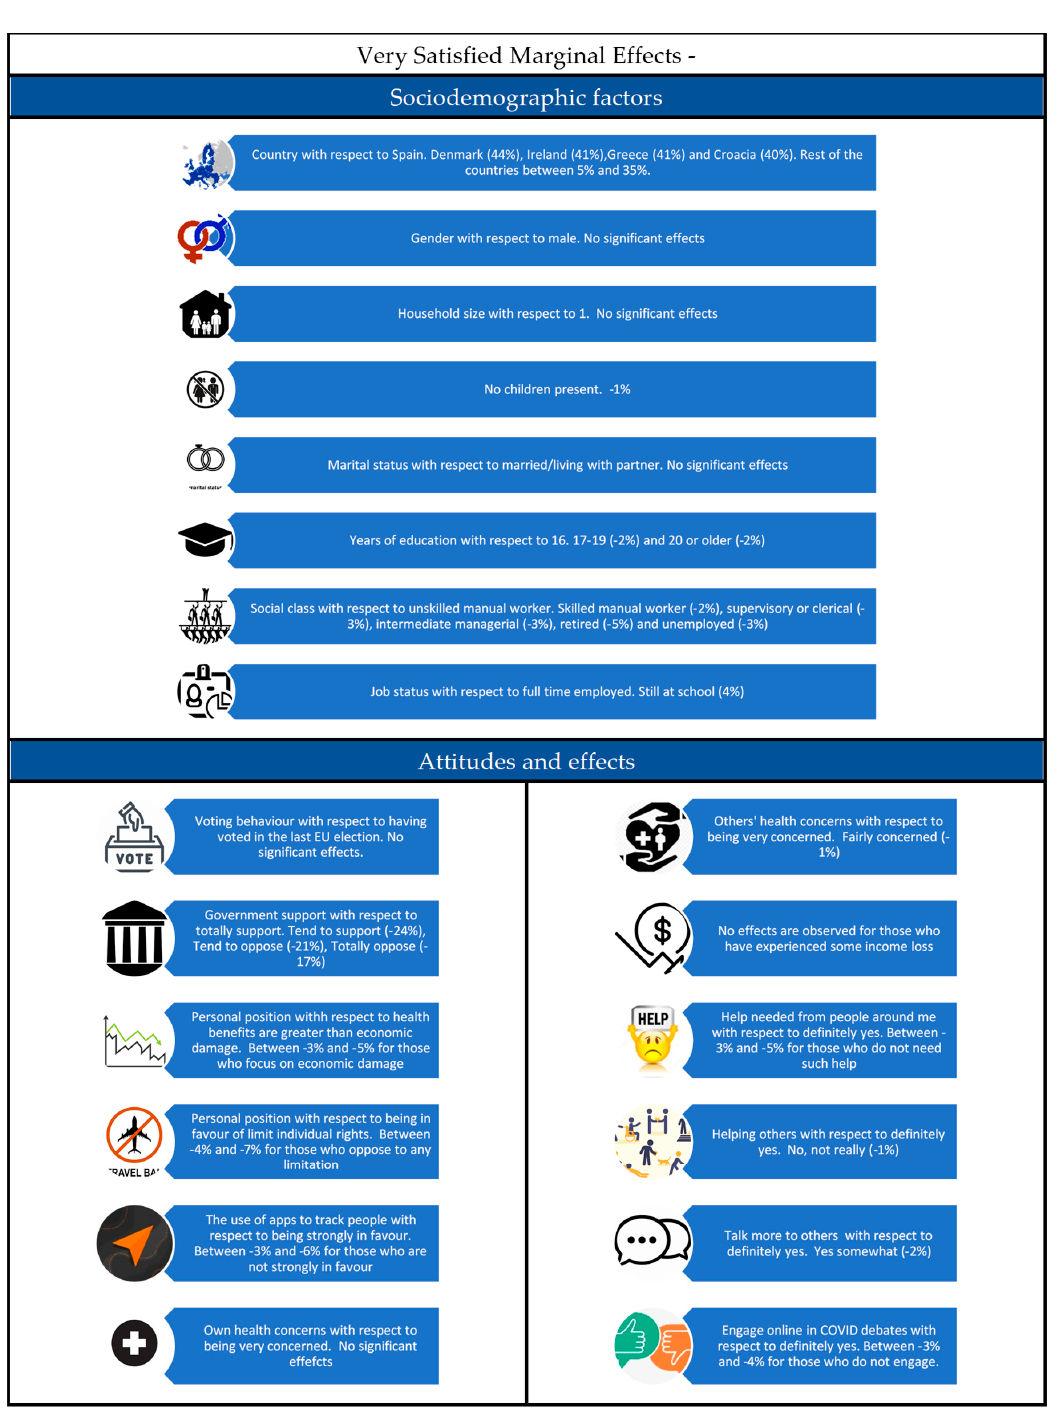
Figure 1. Marginal effects for the experienced satisfaction with the measures taken by the government. (Very Satisfied). (1) The households with no children had one percent less probability of being very satisfied than the households with children; (2) those who had more years of education had two points less probability of being very satisfied than those who ended the education with 16 years or less; (3) with respect to unskilled manual workers, there were at least five classes that had less probability of being very satisfied, especially retired people, who had five points less; (4) with respect to total governmental support, an effect of the lower partisanship citizens showing lower support for the measures was seen ( − 24% and − 17%), but the relationship was not linear; (5) the citizens who focused more on the